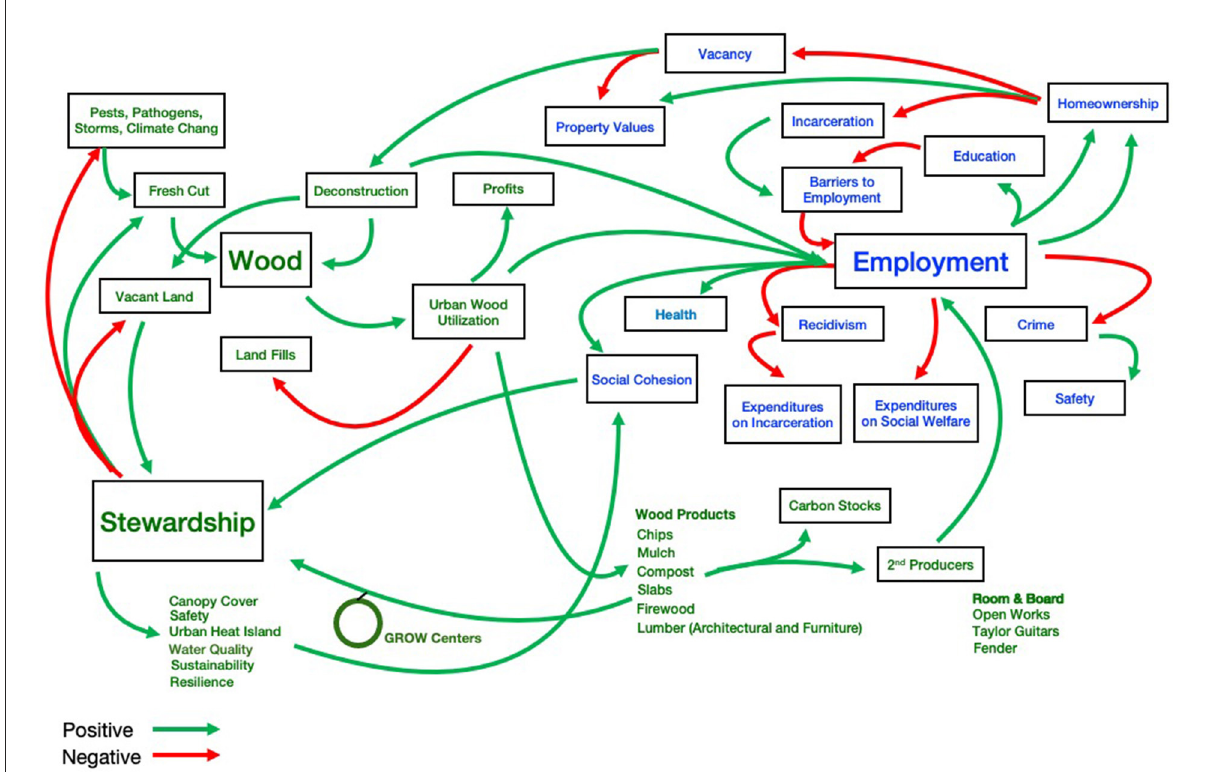
FIGURE5 Baltimore urban wood systems diagram. A complex system, emerging from solving problems of Wood and Employment. Virtuous cycles are developed with both positive and negative